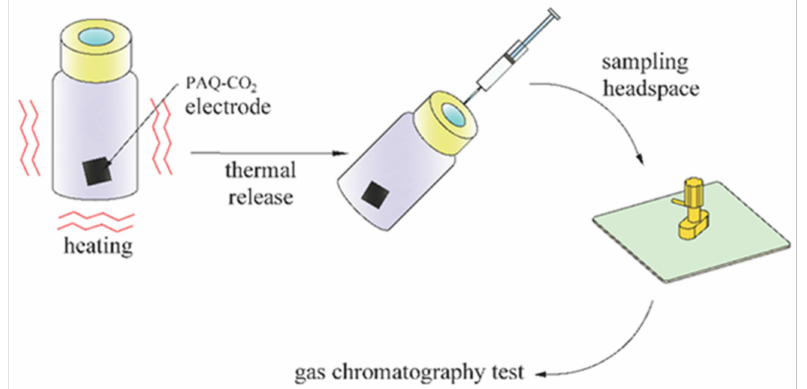
Figure 4. Flow chart of thermal-released CO 2